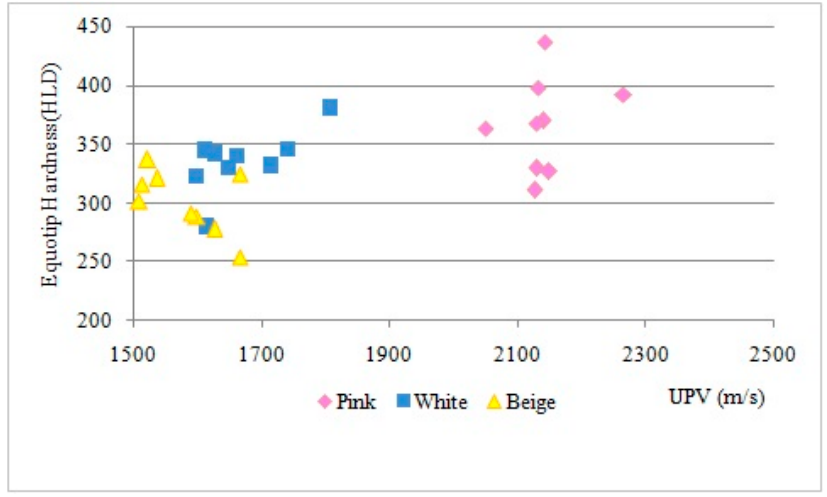
Figure 10. UPV vs. HLD.